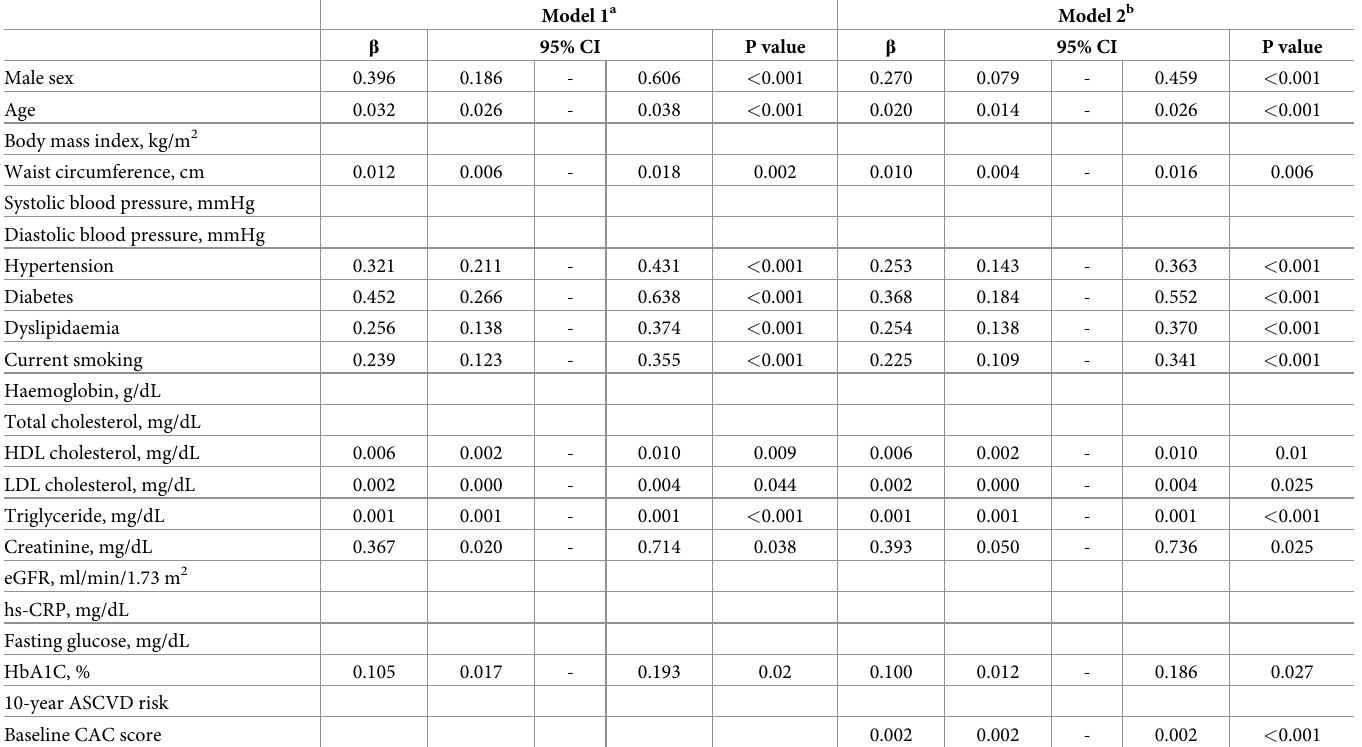
Table 3. Multivariate analysis for factors associated with the CAC progression